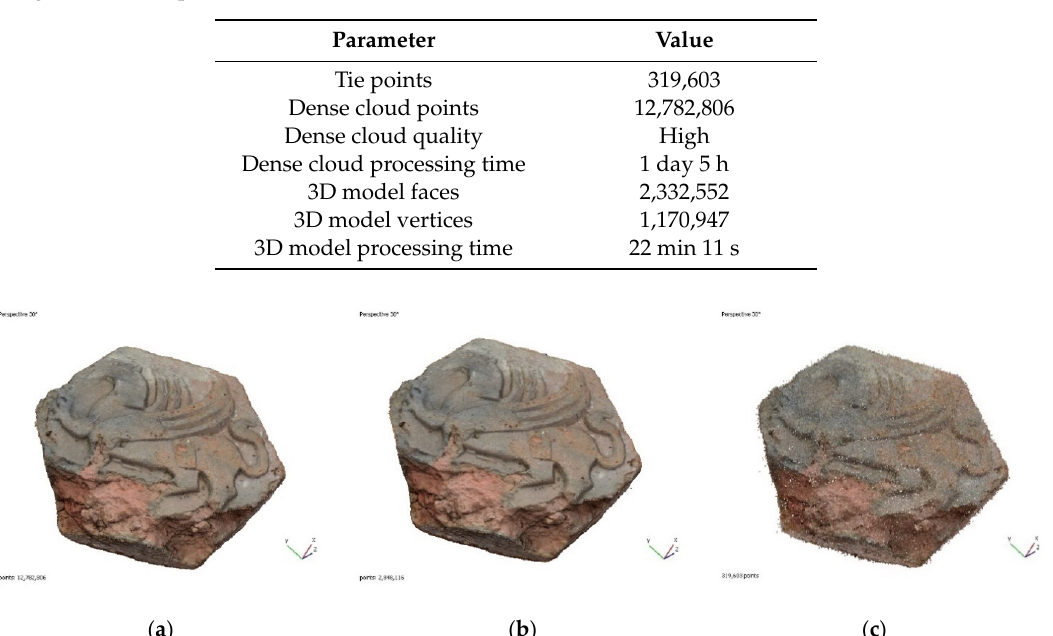
Table 2. An overview of the parameters of a model constructed from the highest density point cloud in Agisoft Metashape.